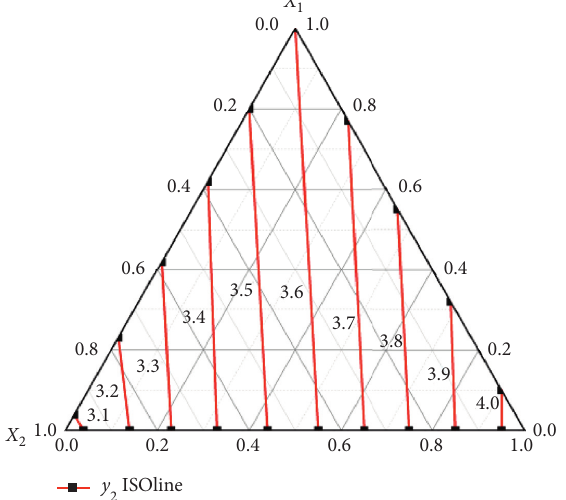
regression equation. 2